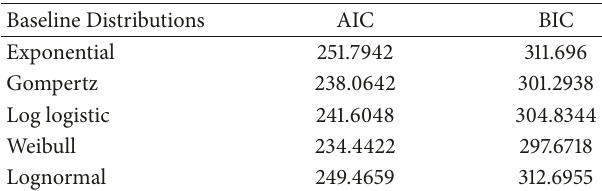
Table 4: AIC and BIC values of shared frailty